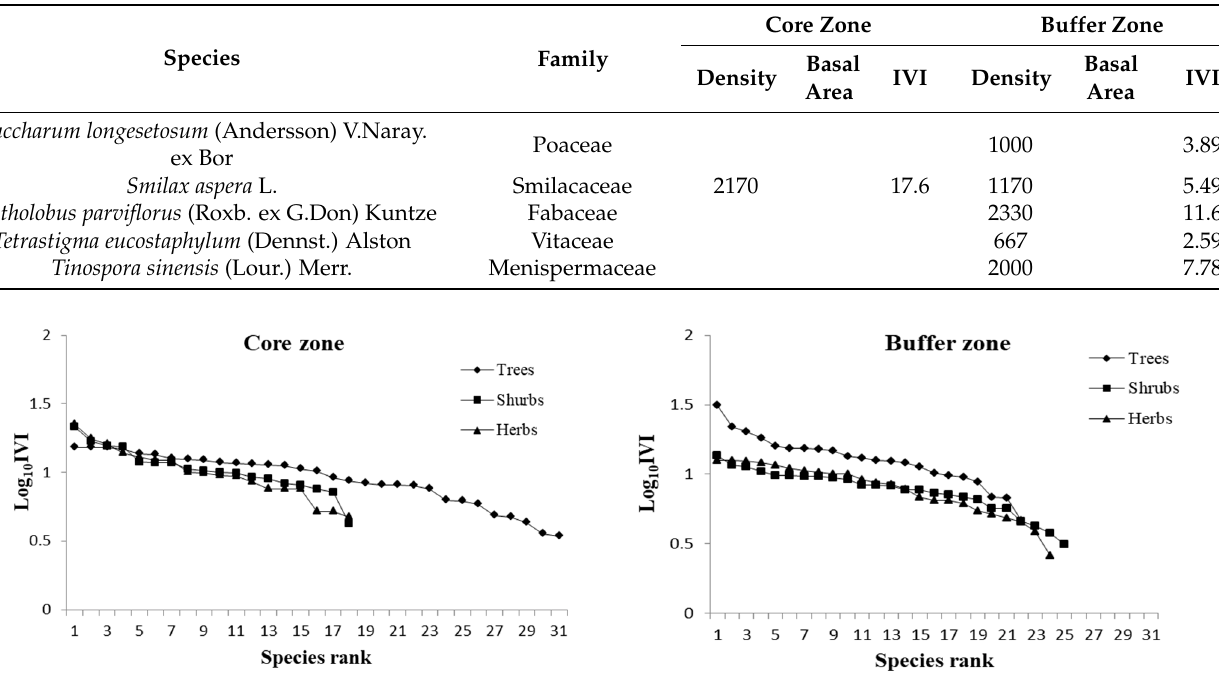
Figure 3. Dominance–diversity curve for trees, shrubs, and herbs in core ( left ) and buffer ( right ) zones in Minkong Community Forest Reserve, Nagaland, India.